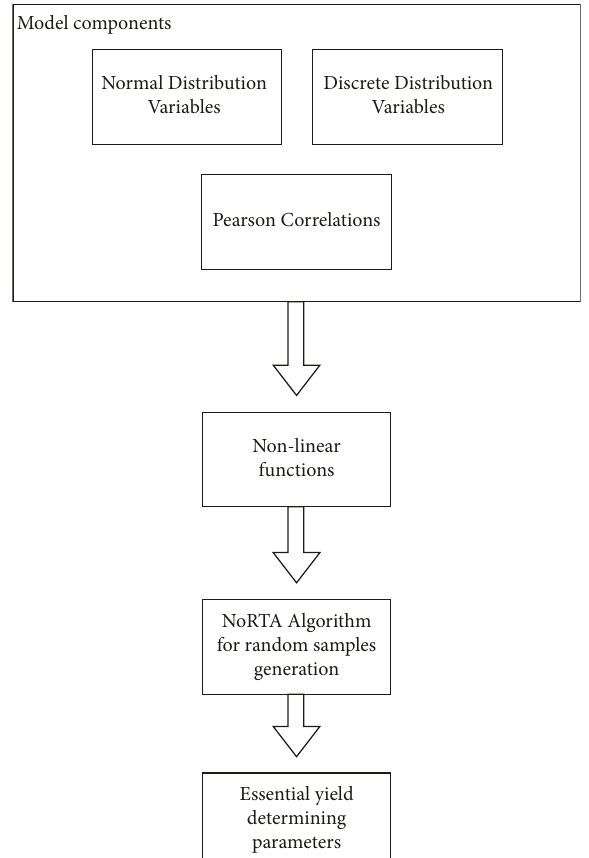
Figure 2: Flow chart presenting the steps used in modelling